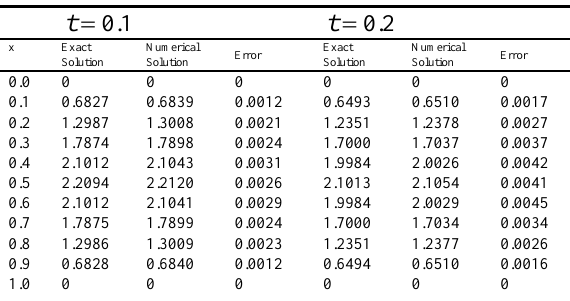
Table 4. Numerical results for at different times.